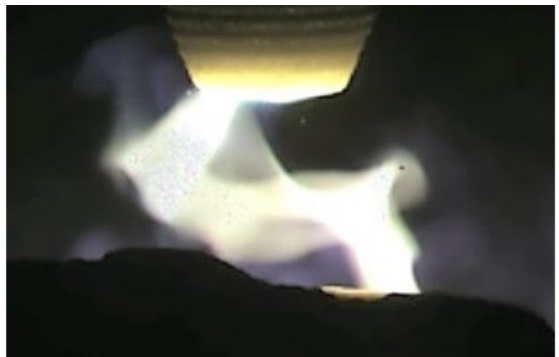
Figure 6. Some examples of the arc geometries in the air in a constant gap [20].